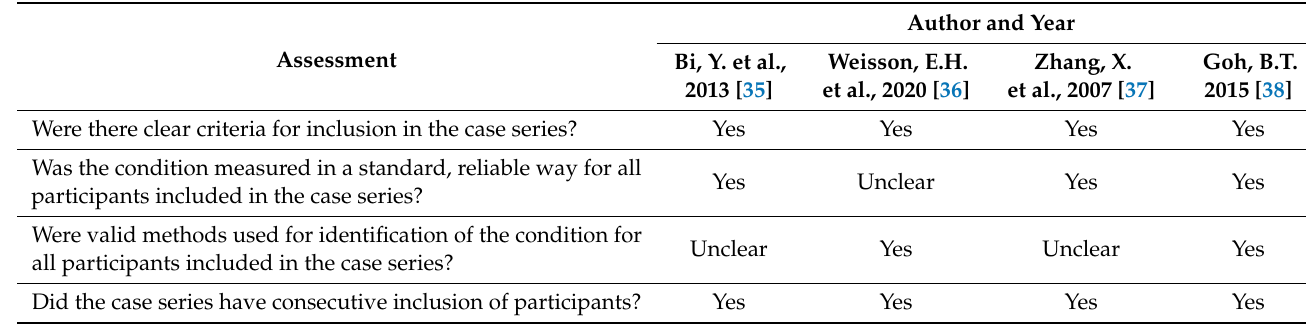
Table 3. Risk of bias for the case